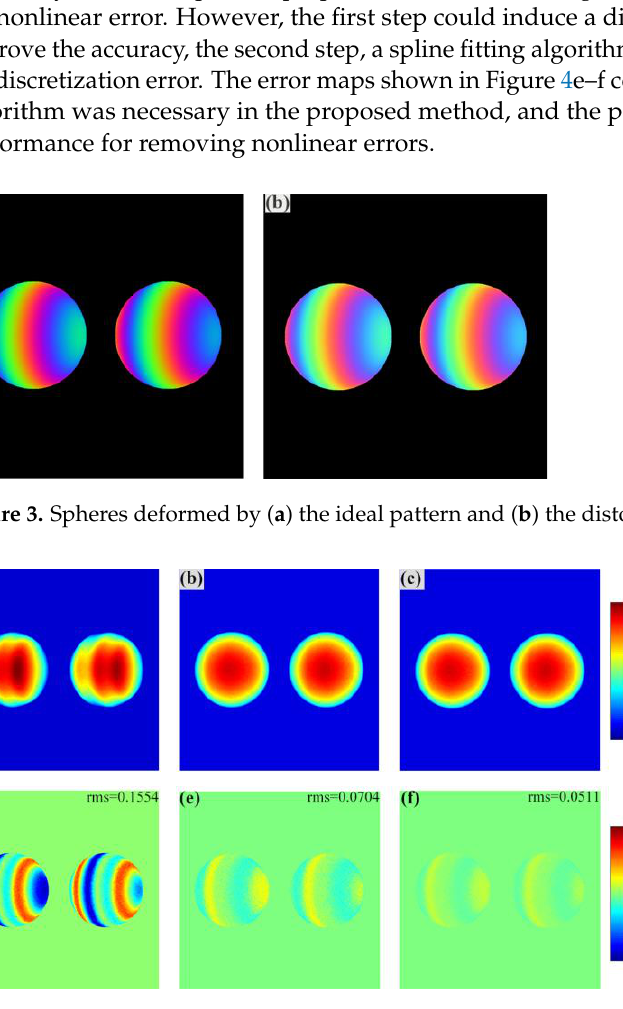
Figure 5. Results of the simulated step heights. ( a ) absolute phase recovered without corrections; ( b ) absolute phase corrected with the proposed method; and ( c ) the ground truth of the simulated ob- ject. Unit: rad.